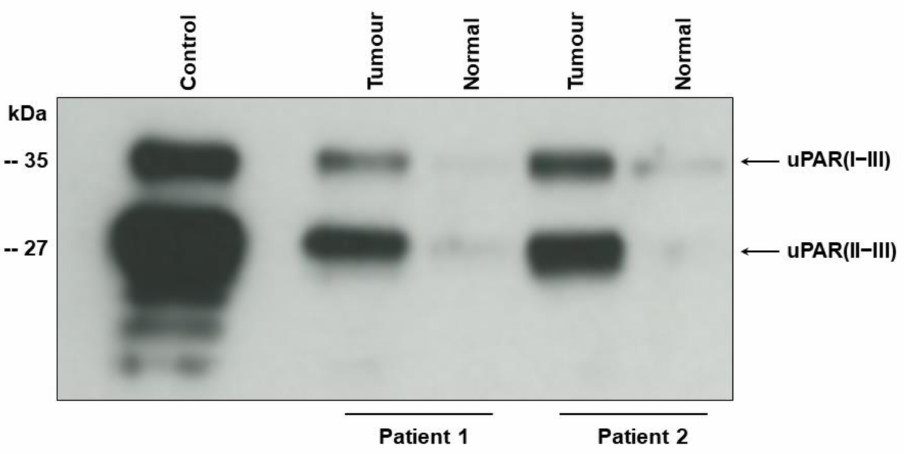
Figure 1. Intact and cleaved uPAR in tumour tissue from two patients with